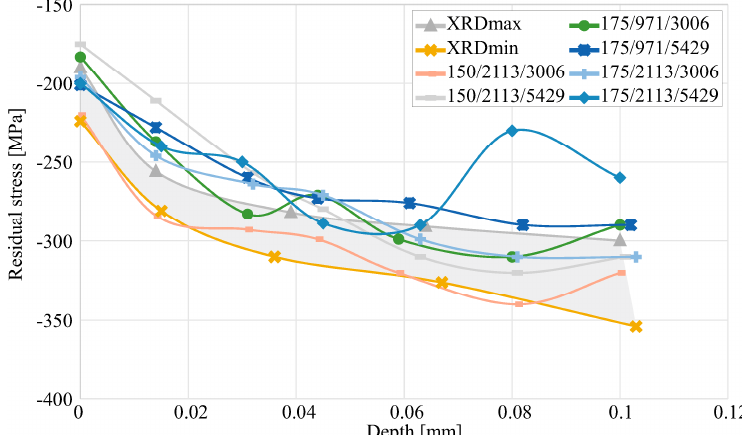
Figure 18. Measured residual stress (XRD) after 10 load cycles for the load combinations shown in Table